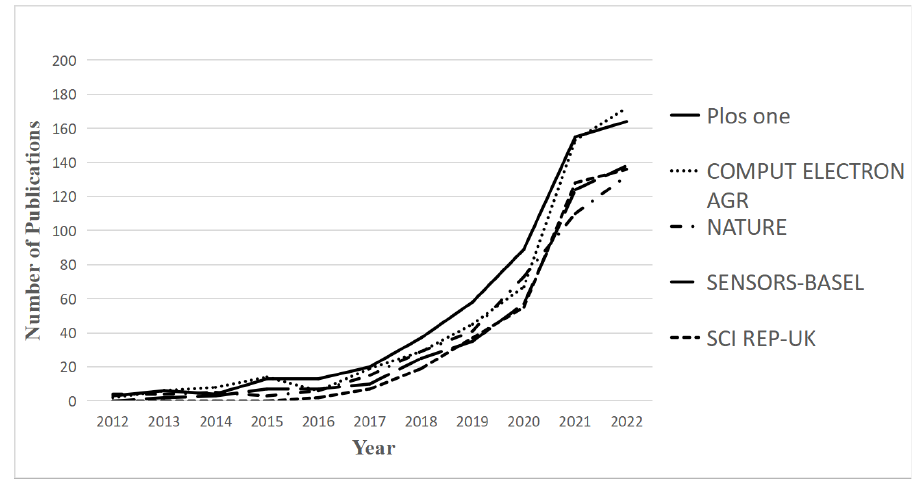
Figure 9. The number of co-citation articles of the top 5 journals in 2012~2022.